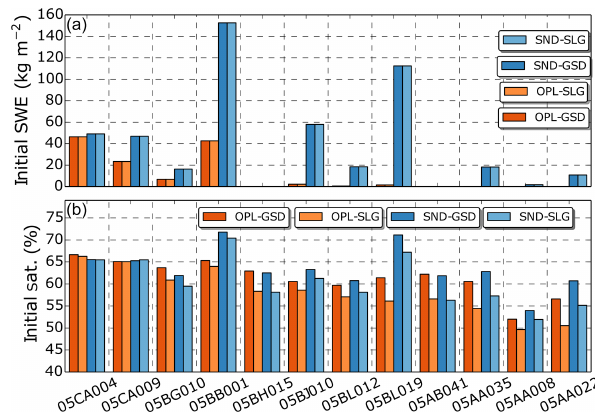
Figure 8. (a) Basin-averaged initial SWE and (b) basin-averaged initial soil saturation for the top 50cm of the soil column on 18 June 2013 at 12:00UTC for the 12 basins shown in Fig 2. Results from four GEM-Hydro simulations providing initial conditions are shown. Their characteristics are given in Sect.